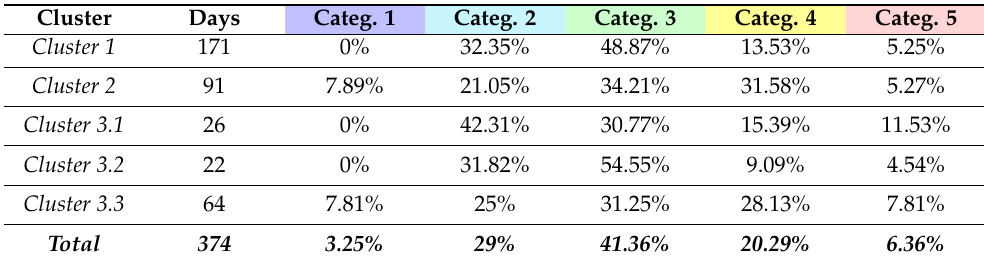
Table 10. Distribution of days for each cluster based on EE category. Each EE Category is associated with a color as depicted in Figure 12. Categ.